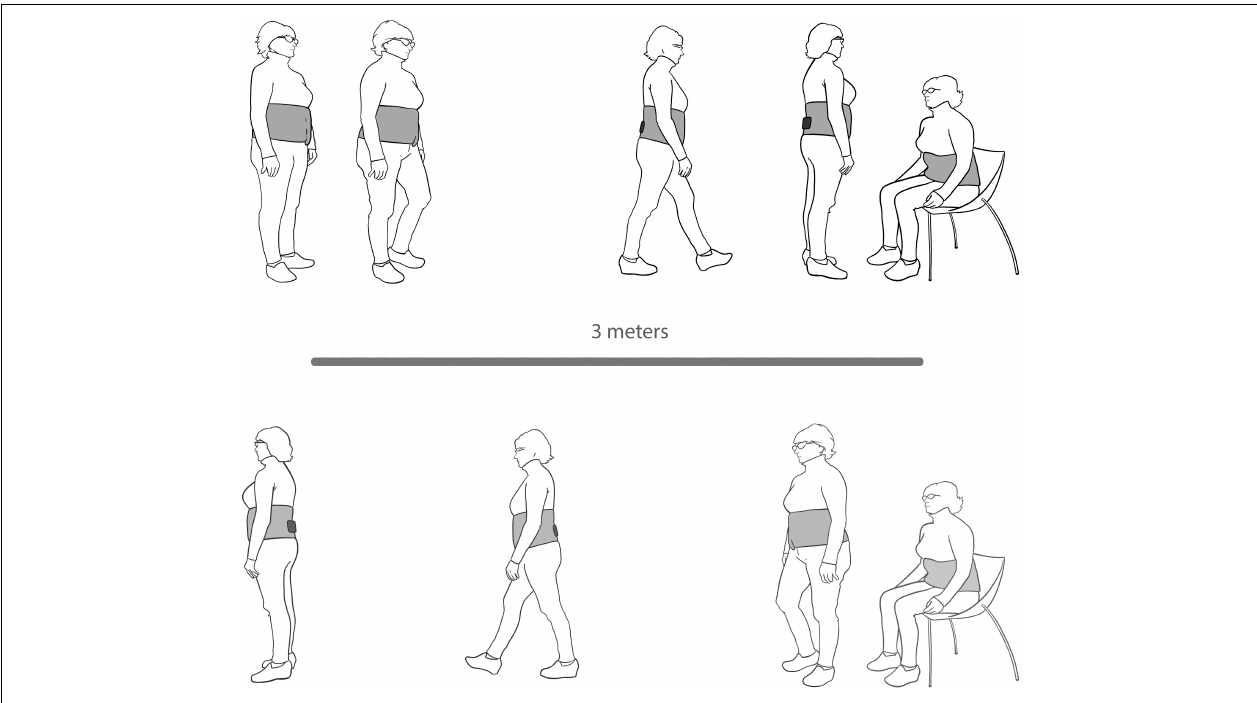
FIGURE 2 | FallSkip